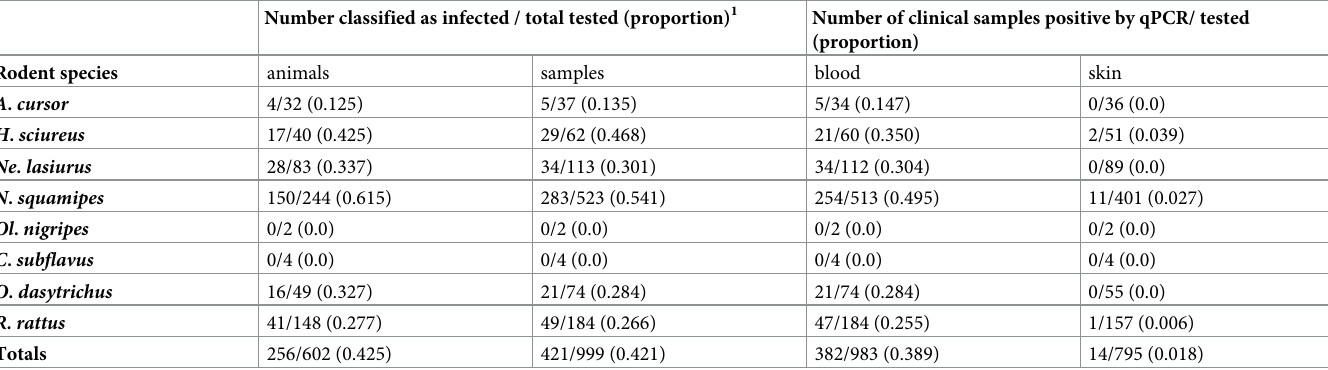
Table 2. Number and proportion of rodents and clinical samples classified as infected 1 and positive by qPCR for L . ( V .) braziliensis . Number classified as infected / total tested (proportion)